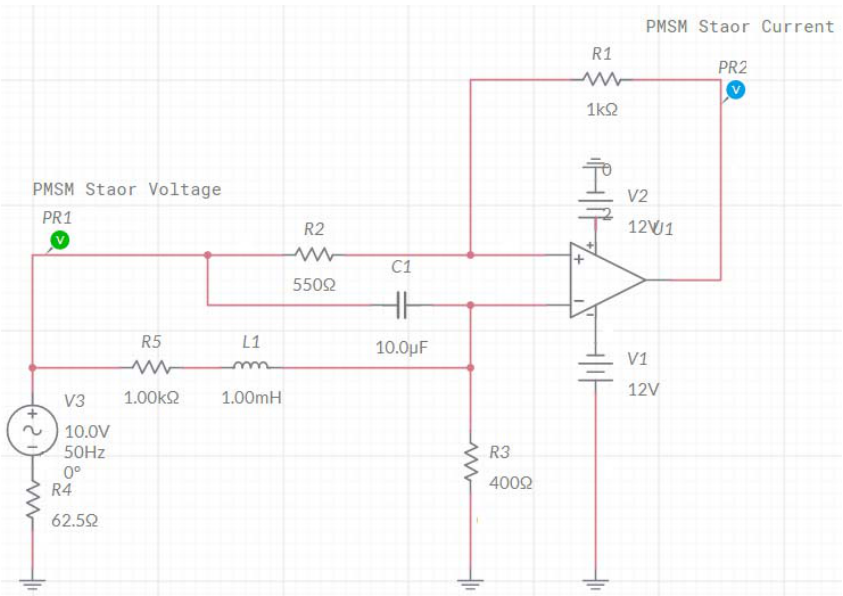
Figure 12. PMSM stator simulation model.